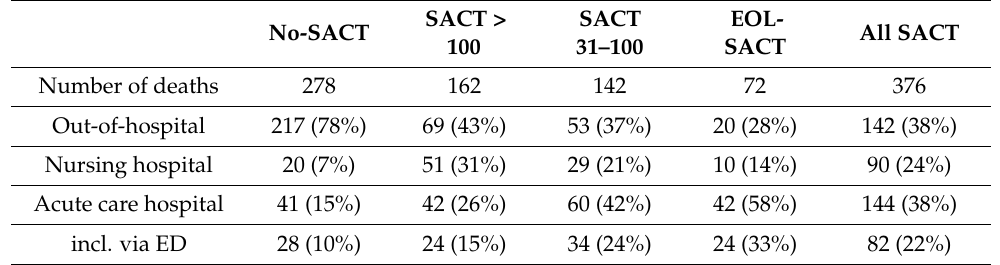
Table 4. Place of death among study population.